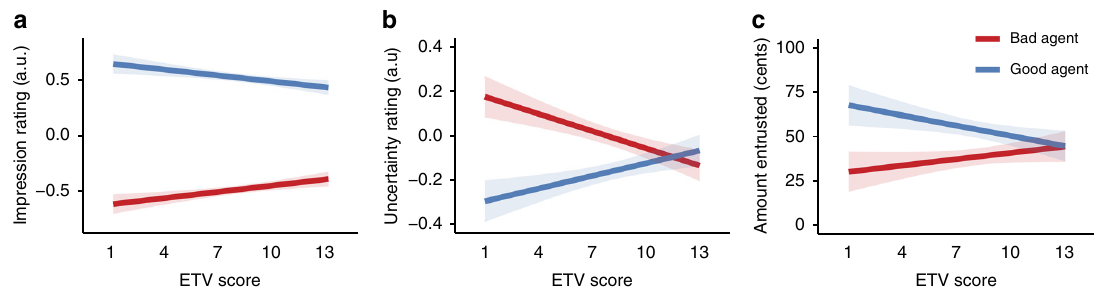
Fig. 3 Model estimates showing diminishing effects of agent with increasing exposure to violence. Participants with higher ETV scores showed less differentiation in their subjective impressions of good (blue line) vs. bad (red line) agent ’ s moral character ( a ) and reported smaller discrepancies in the uncertainty of their impressions of good and bad agents ( b ). Higher ETV scores also resulted in smaller discrepancies in the amounts that participants entrusted with good vs. bad agents in a one-shot trust game ( c ). Y -axis in fi gures a and b denote standardized values ( z -scored). Error bands represent 95% con fi dence intervals. Source data are provided as a Source Data fi